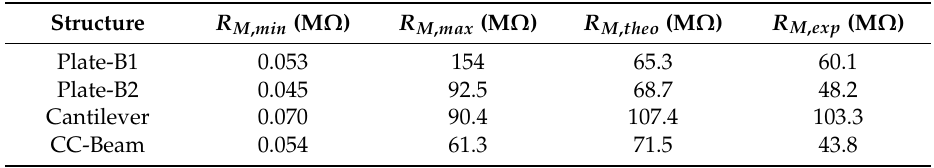
Table 3. Motional resistance bounds providing thermomechanical noise values at resonance beyond the circuit noise together with the theoretical resistance and the experimentally fitted ones. The theoretical predictions are computed assuming atmospheric pressure operation. Bias voltage is 50 V for all resonators, except for Plate-B1 that is 40 V.